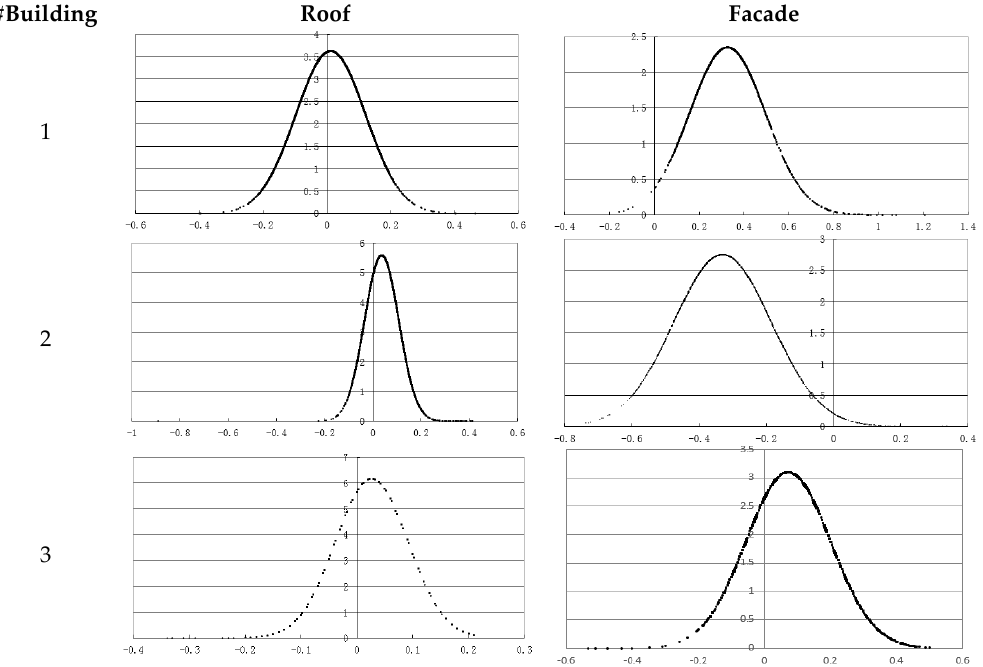
Figure 17. Normal distribution of distance from roof plane and façade plane to laser points. Table 6. Evaluation of semantic recognition for case study 1.